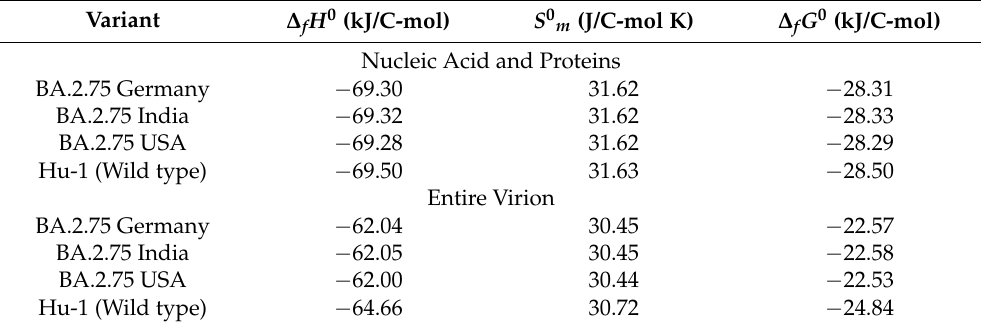
Table 7. Standard thermodynamic properties of the live matter or SARS-CoV-2 nucleic acid and proteins and entire virions. Nucleic acids and proteins represent the viral RNA together with the nucleoprotein, membrane proteins, and spike protein. On the other hand, the entire virion includes the nucleic acid, proteins, and envelope lipids. The table contains data on the standard enthalpy of formation, ∆ f H 0 , standard molar entropy, S 0 m , and standard Gibbs energy of formation, ∆ f G 0 .